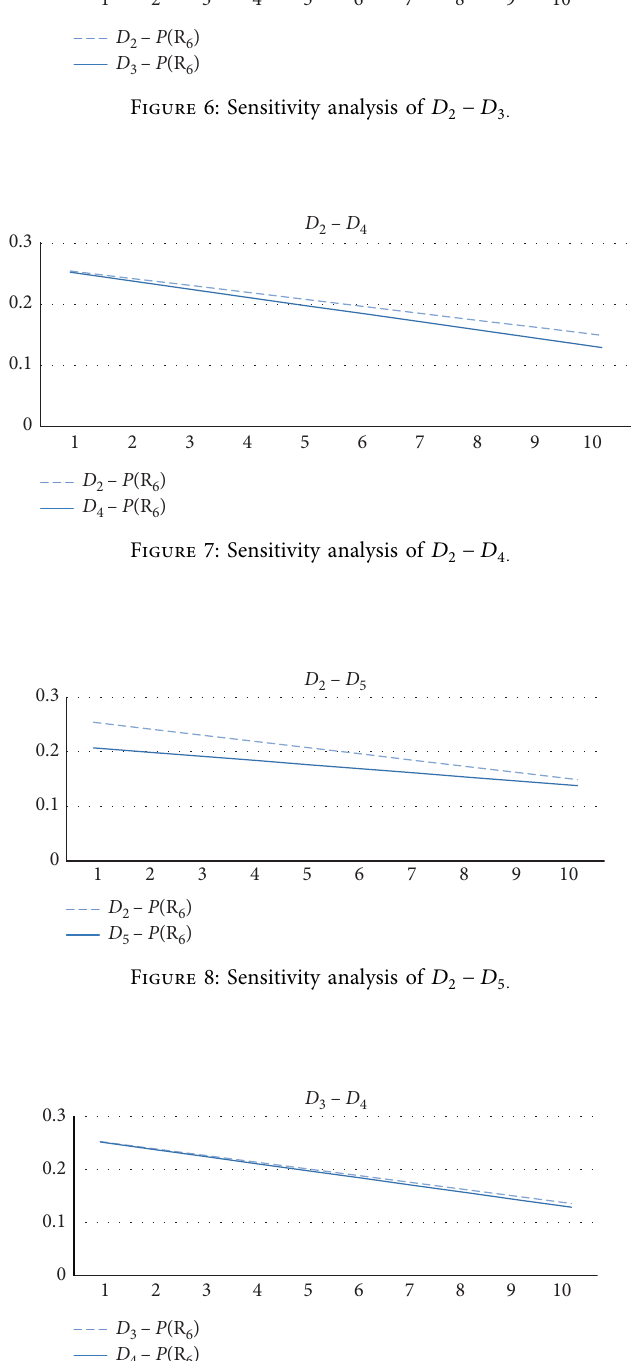
Figure 9: Sensitivity analysis of D